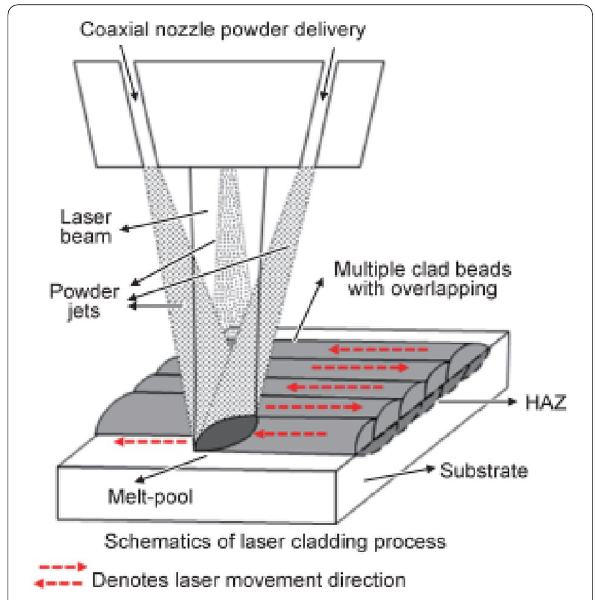
Figure 15 Schematic diagram of LMD process [69]